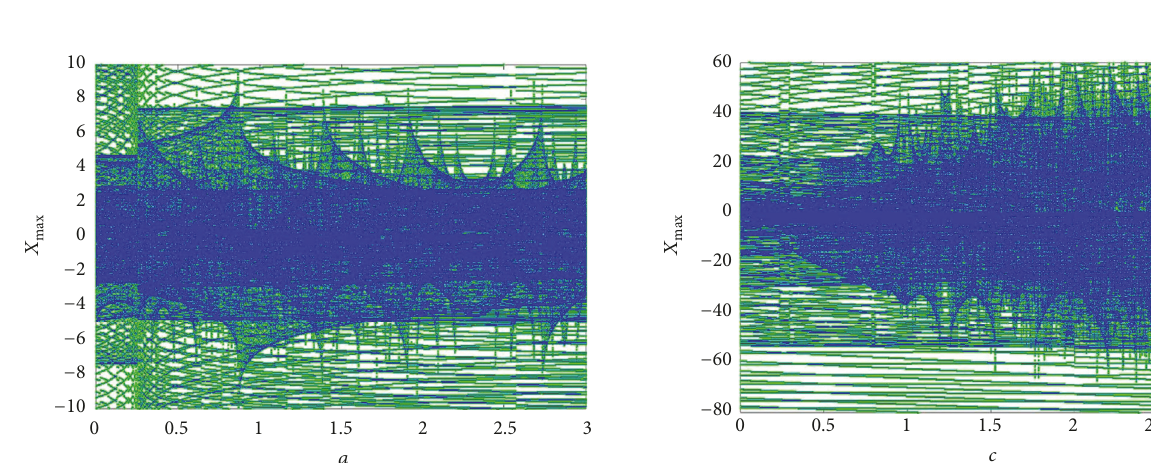
Figure 7: Bifurcation plots for parameter 𝑐 .